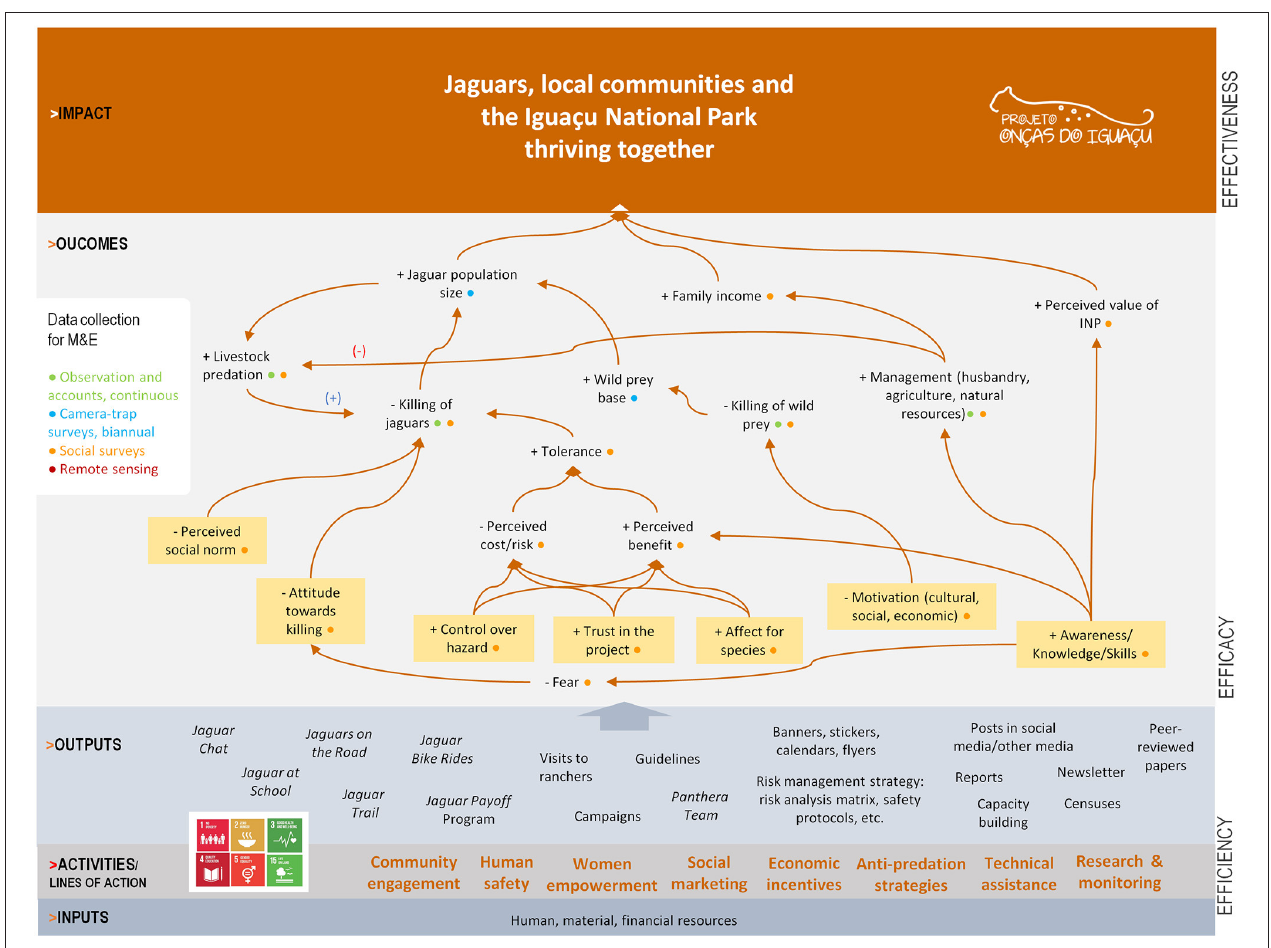
FIGURE 3 | Sample custom presentation of a theory of change: the ToC of Jaguars of Iguaçu